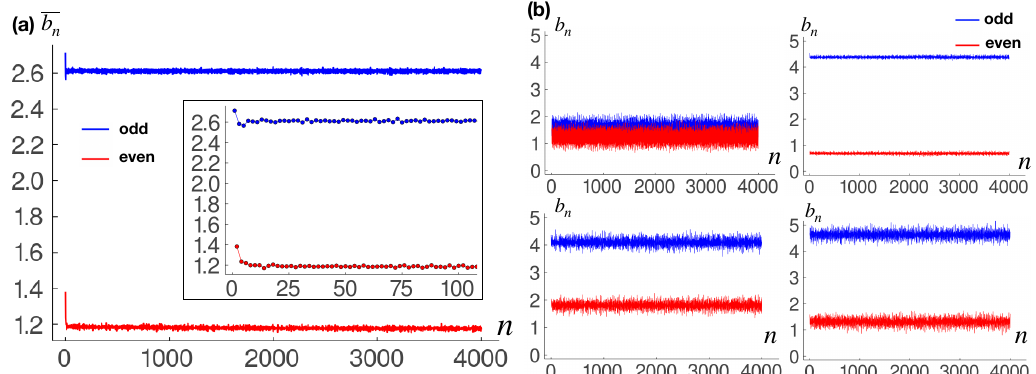
Figure 12: (a) The disorder-averaged Lanczos coefficients b from the MBL phe- n nomenological model Eq. (18) for the initial operator ˆ τ x and the parameters L = 14, 0 ξ = 0.6 and W = 5.0 . The Lanczos coefficients have an even-odd alteration but larger odd values, approaching constants in large n . Inset: The disorder averaged Lanczos coefficients b at small n . (b) The Lanczos coefficients b from the MBL n n phenomenological model for several disorder